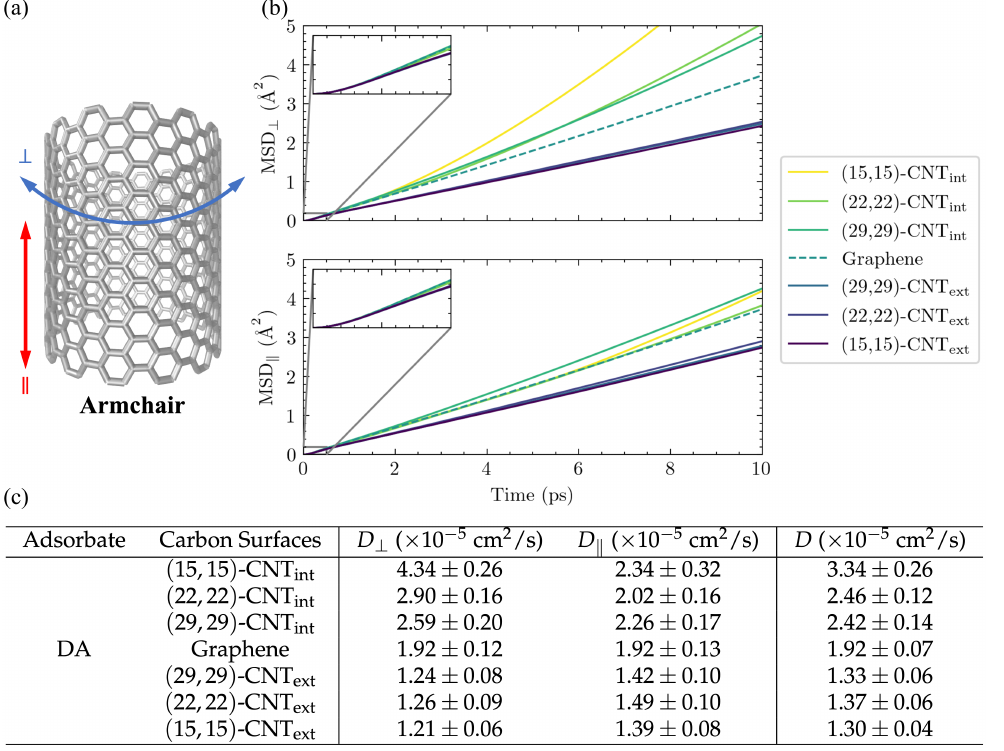
Figure 3. DA diffusion on differently curved carbon surfaces. Results are shown here for the diffusion of DA on the interior (int) and exterior (ext) surfaces of armchair CNTs of varying diameters and flat graphene. ( a ) The armchair designation [45] refers to the edge morphology of the CNT along the perpendicular direction. Diffusion on the surface in the same direction as the CNT axis is referred to as parallel ( (cid:107) ), while that around the circumference of the CNT is denoted as perpendicular ( ⊥ ). All CNTs presented in this table are 100.698 Å along the periodic (cid:107) direction, and the graphene sheet is 98.2419 × 97.8420 Å 2 in size and periodic in two directions along the surface. ( b ) The MSDs as a function of time are shown in both surface directions: ⊥ (top panel) and (cid:107) (bottom panel). ( c ) The diffusion constants D ⊥ , D (cid:107) , and the overall 2D D values are computed from linearly fitting the MSD curves in ( b ) using the Einstein relation, Equation (S4), over the 4–10 ps range. In both ( a , b ), the carbon surface results are organized from most concave to the most